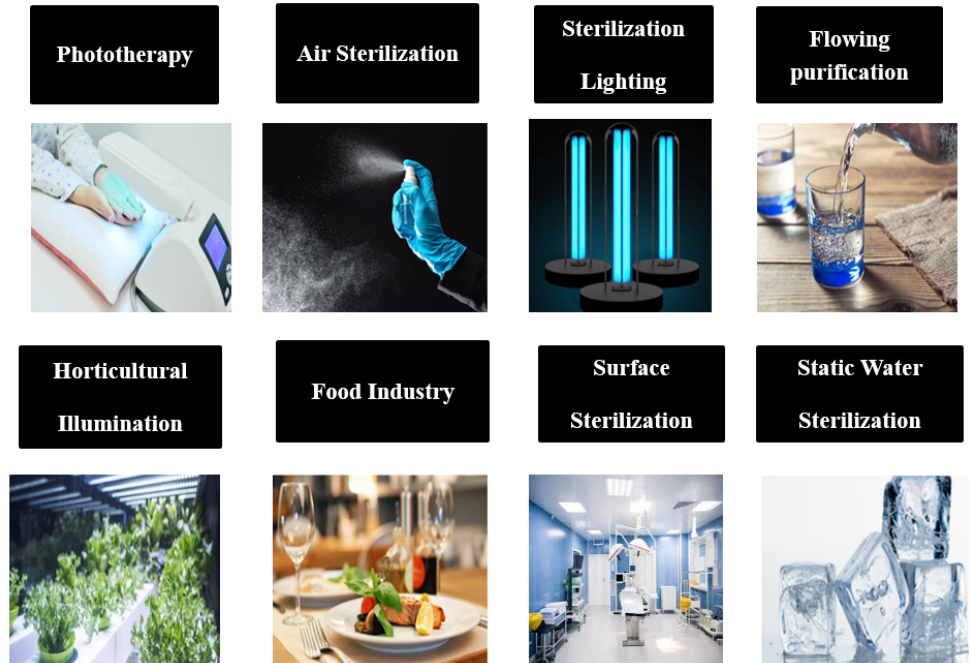
Figure 2. Application of near UV-LEDs.